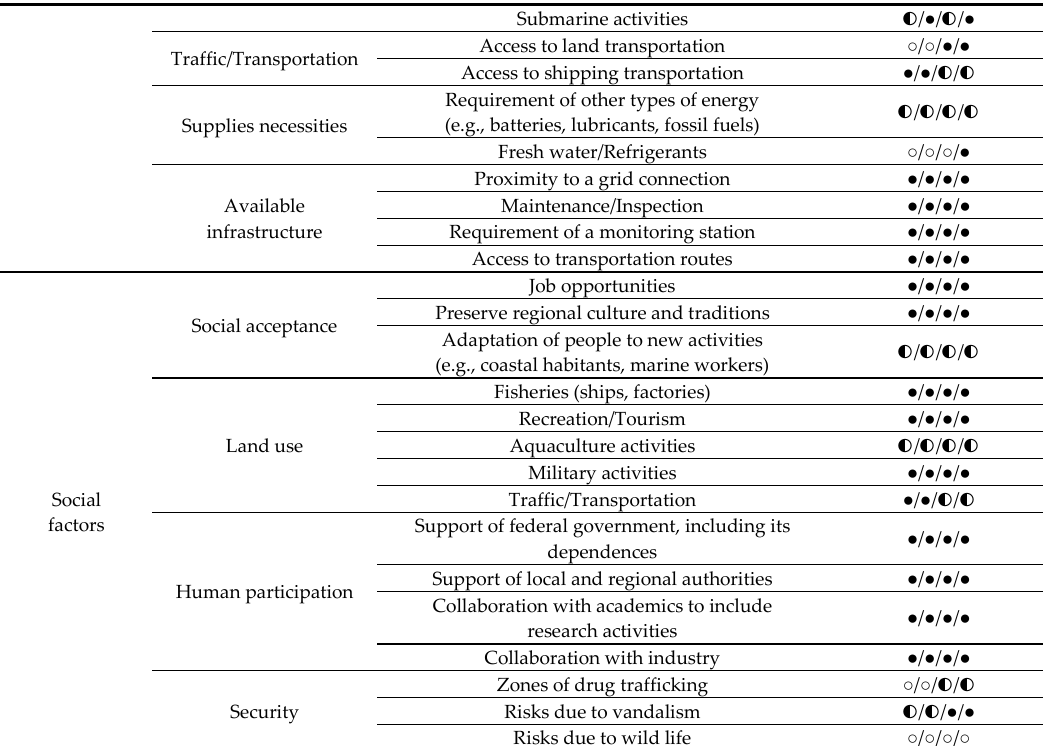
Table 2. Cont. J. Mar. Sci. Eng. 2019 , 7 , x FOR PEER